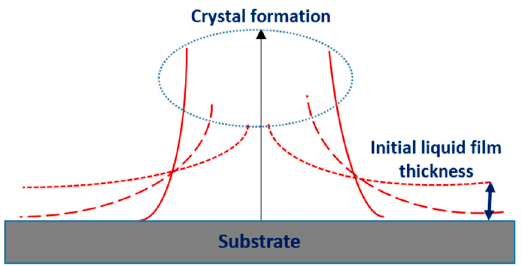
Figure 1. Schematic of the emergence of a crystal from a liquid film with time, causing possible dewetting adjacent to a protruded crystal (crystallization dewetting). dewetting adjacent to a protruded crystal (crystallization